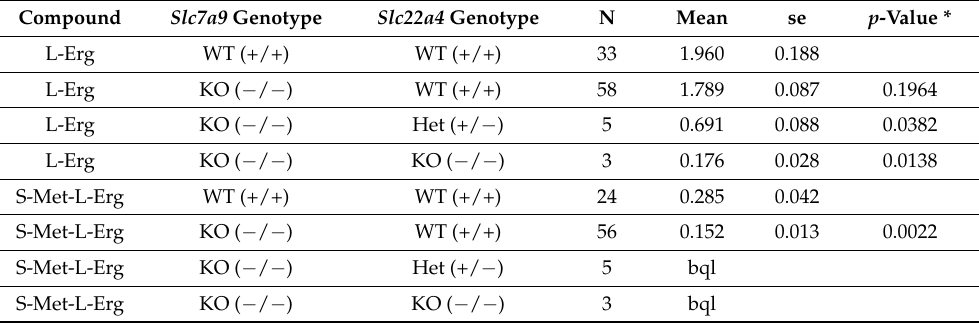
Table 2. L-Erg and S-Met-L-Erg 24 h urine concentration when knocking out Slc22a4 in cystinuric Slc7a9 -/- mice. Number of mice (N), mean and standard error (se) in µ M and p -value. *, The p -value versus WT Slc7a9 and WT Slc22a4 , respectively. bql, bellow quantification limits. All groups contain male and female